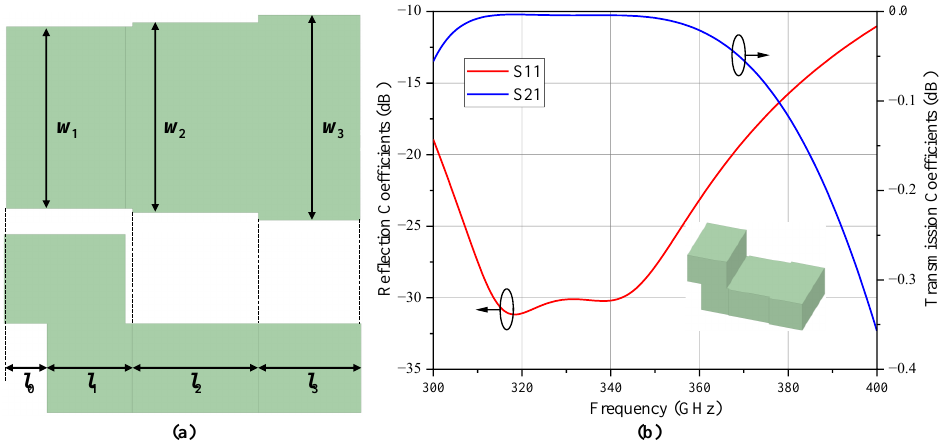
Figure 8. ( a ) The configuration of the proposed 90 ◦ E-plane waveguide bend. ( b ) The S-parameters simulation results of the 90 ◦ E-plane waveguide